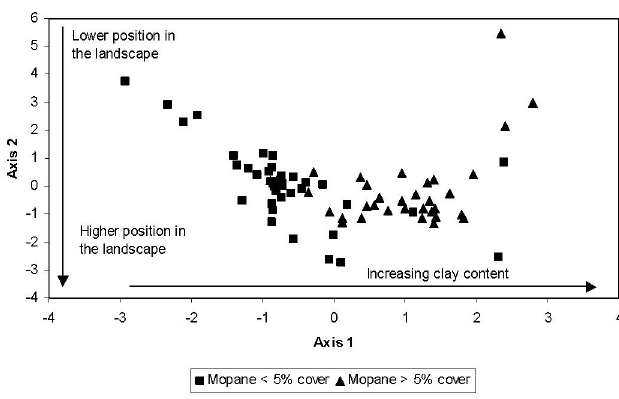
Fig. 5. C ANOCO ordination of 73 vegetation sample plots in the Parque Nacional de Banhine (excluding sample plots along major drainage lines, on floodplains and on termite